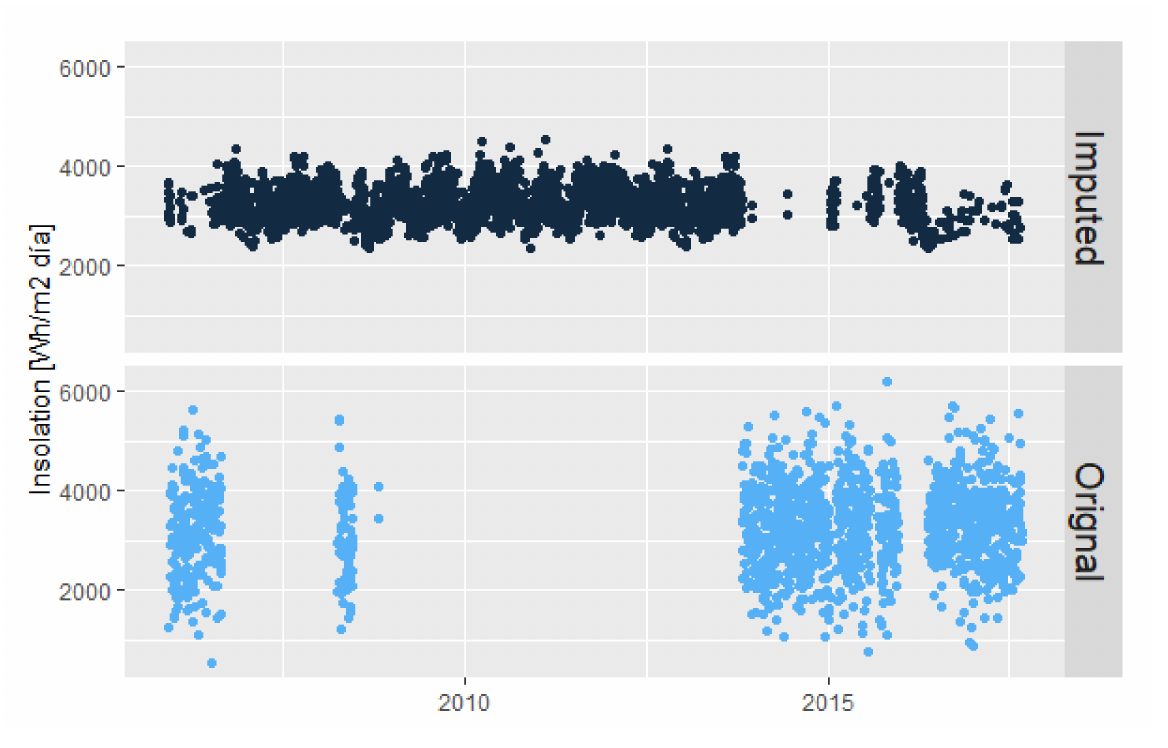
Figure 17. La Josefina imputation.